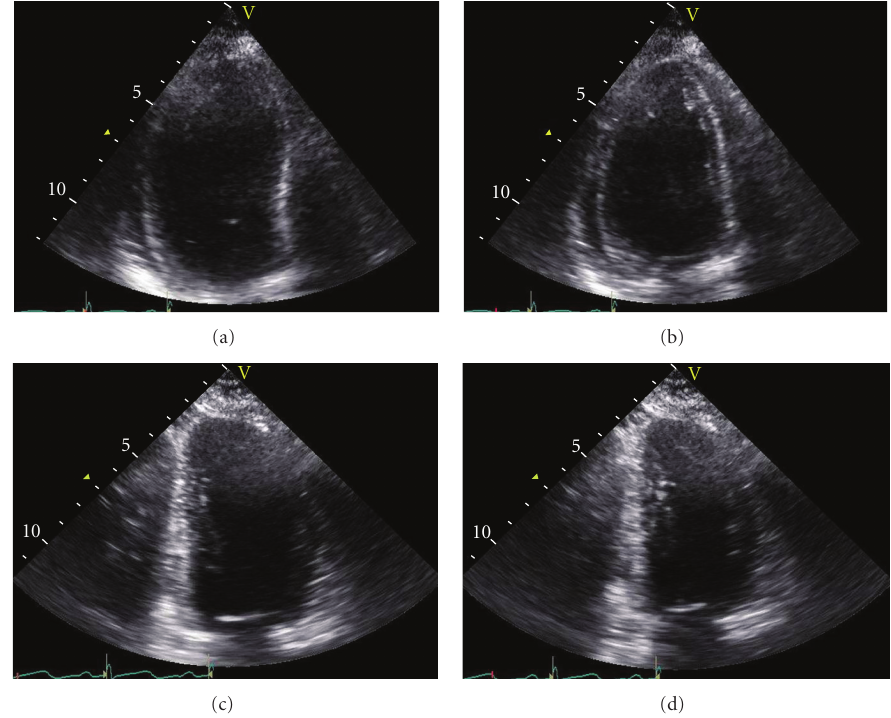
Figure 1: End-diastolic (a) and end-systolic (b) frames of two chamber view on initial echocardiography taken 12th day showing severe left ventricular systolic dysfunction with akinesia of the left ventricular base and mid-portion, and hypercontractility of the apex, and a followup echocardiography at the end of diastole (c) and systole (d) taken 28th days showing nearly normalized cardiac function without regional wall motion